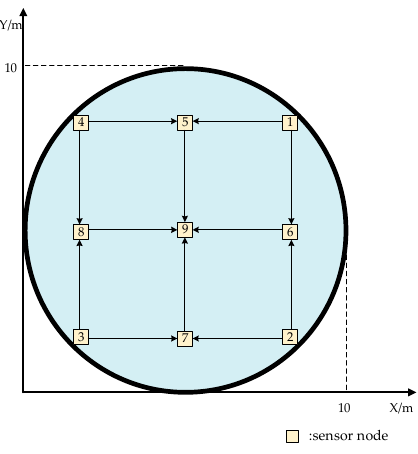
Figure 6. Sensor array of temperature measurement.